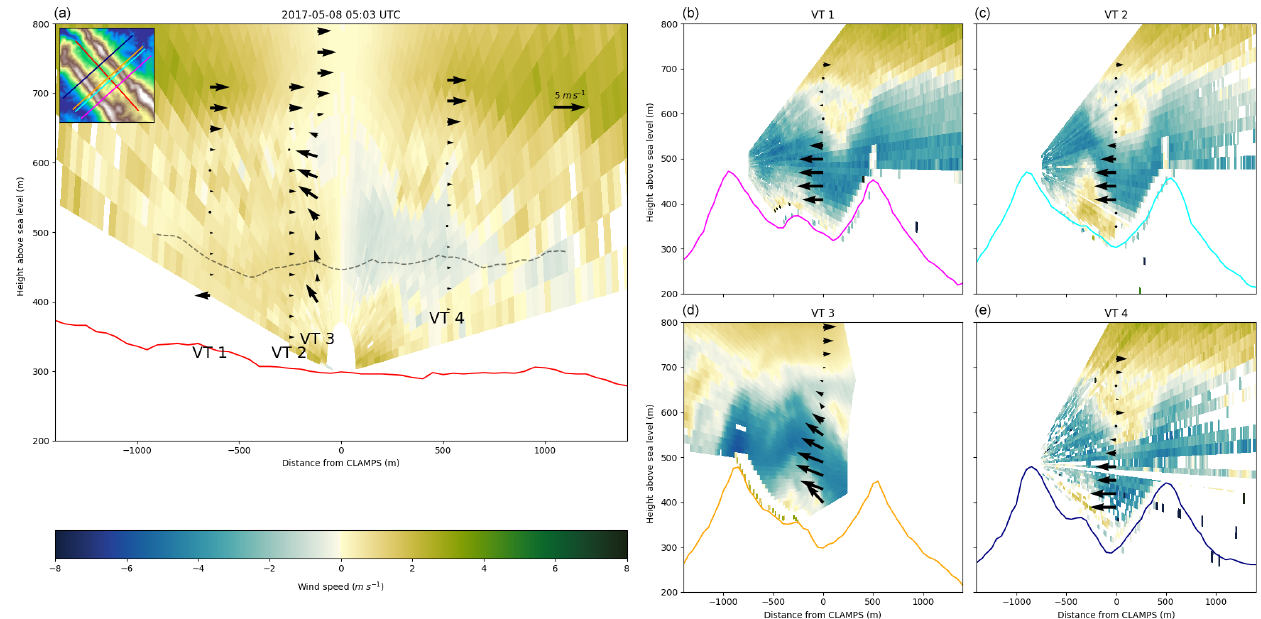
Figure 12. Same as Fig. 11 but for 05:03UTC. Note the different structure of the wave and the shear layers in the cross-valley winds. Also note the different strengths of the